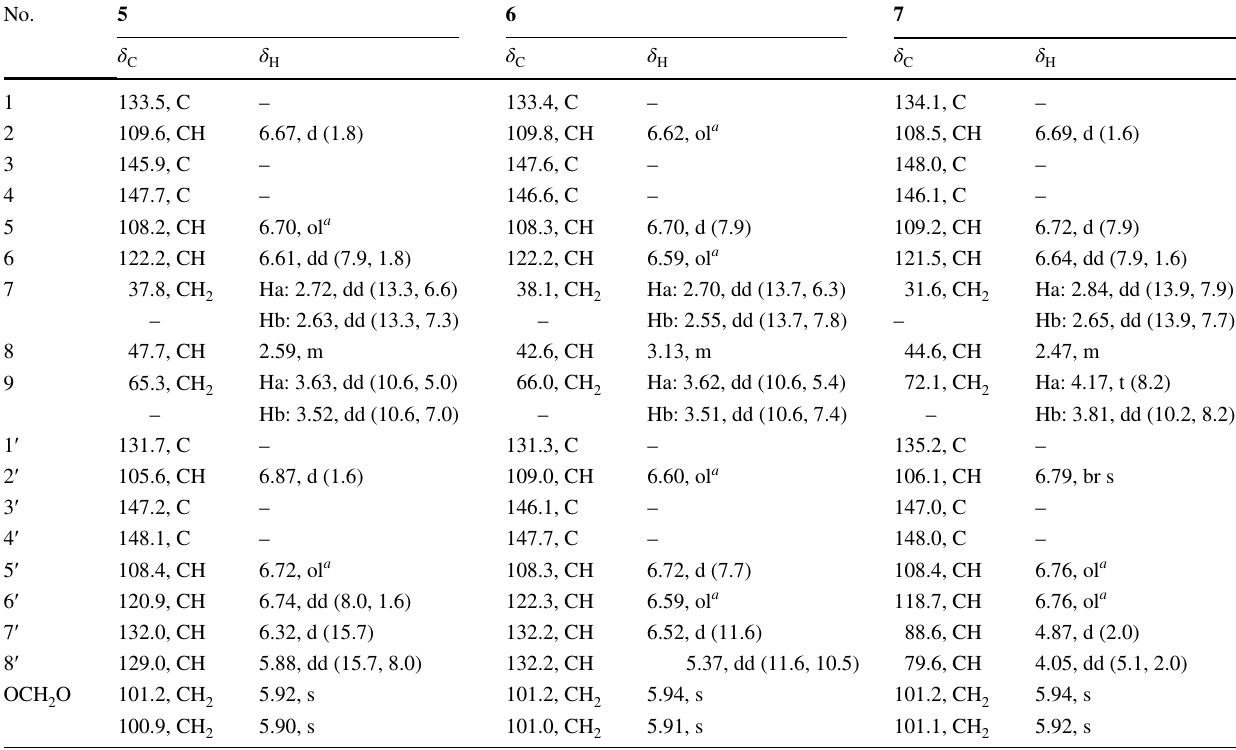
Table 3 Cytotoxic activity of compounds against HepG2 cells